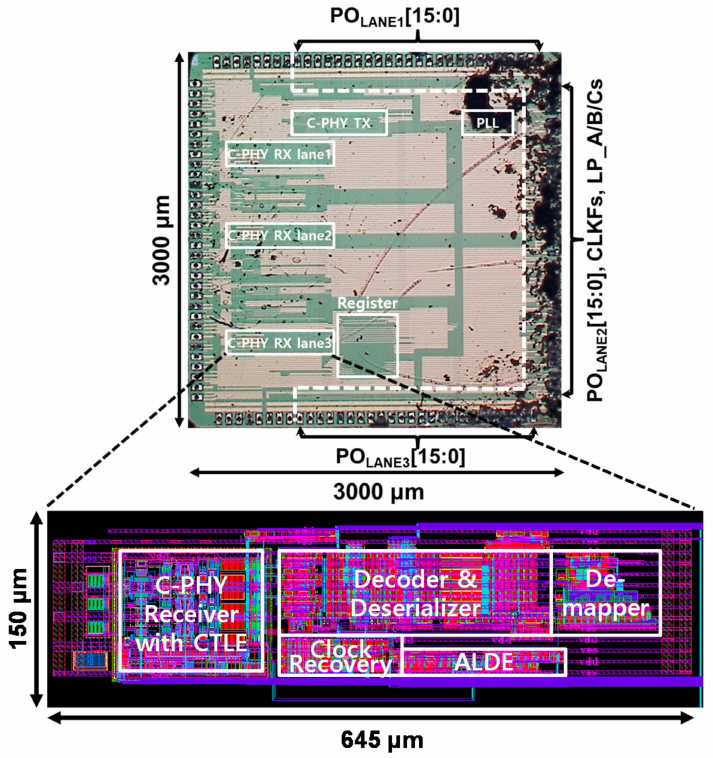
Figure 13. Microphotograph of implemented MIPI C-PHY receiver